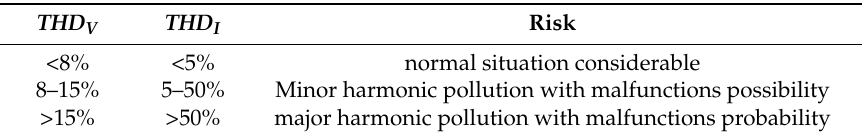
Table 3. Current and Voltage total harmonic distortion allowing values and their associated risks (courtesy: Interpreting European norm (EN) 50160 and International Electrotechnical Commission (IEC) standard 61727). THD—total harmonics distortion. THD V THD I Risk <8% <5% normal situation considerable 8–15% >50% major harmonic pollution with malfunctions probability